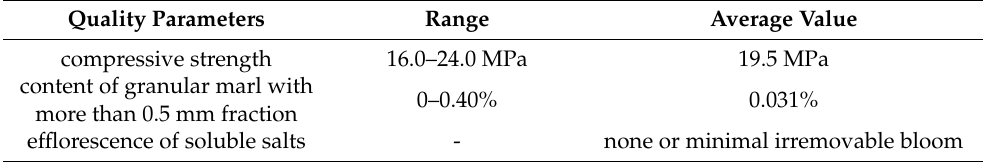
Table 5. Selected quality parameters of tested ceramic building materials (clay masonry units).